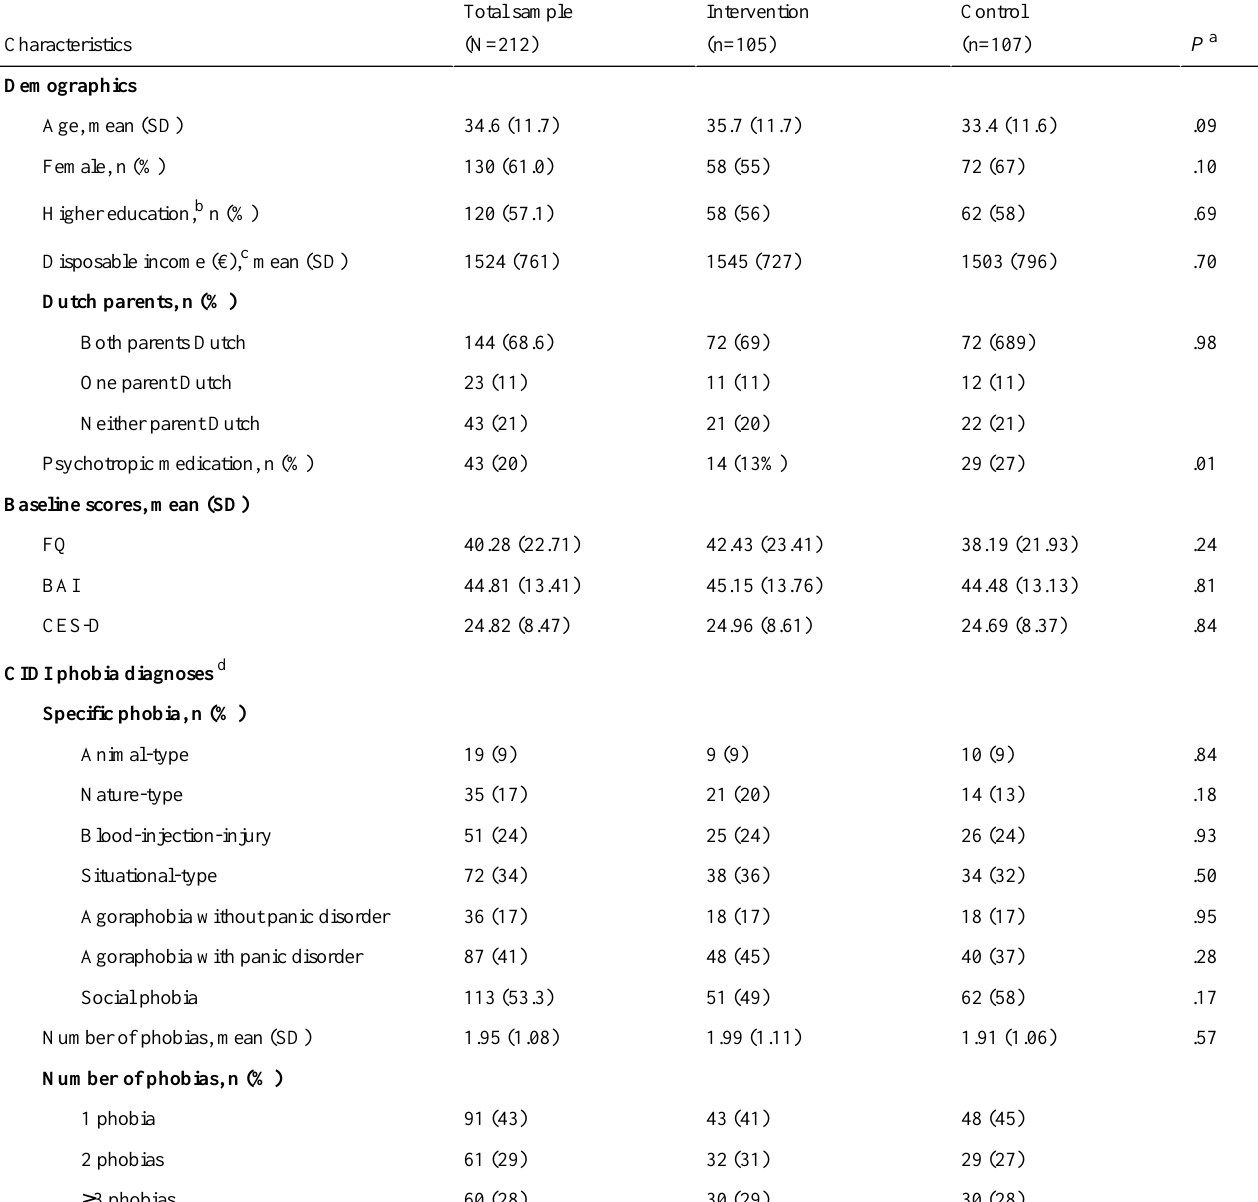
Table 1. Baseline characteristics of